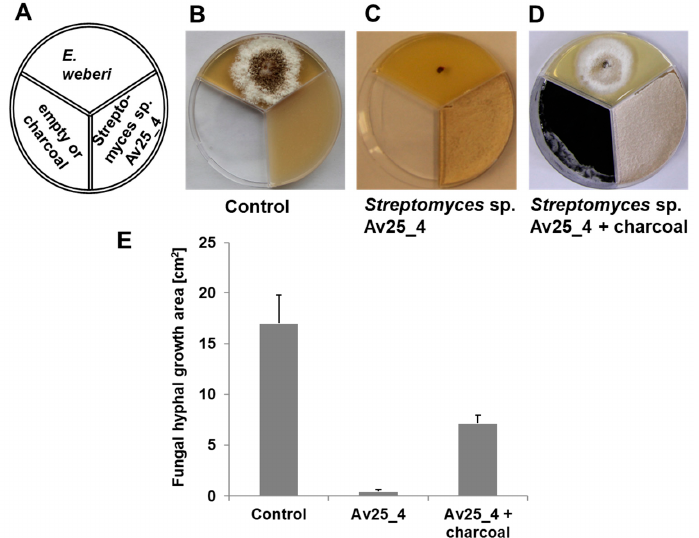
Figure 2. Antifungal activity of volatiles produced by Streptomyces sp. Av25_4 against E. weberi with and without activated charcoal in the third compartment. ( A ) Scheme of the experimental setup. ( B ) E. weberi grown for 4d in the first compartment. ( C ) E. weberi grown for 4d in first compartment and Streptomyces sp. Av25_4 grown for 7d in the second compartment. ( D ) E. weberi grown for 4 d in the first compartment, Streptomyces sp. Av25_4 grown for 7d in the second compartment and 2g acti- vated charcoal in the third compartment. ( E ) Quantification of the E. weberi growth area analyzed by image J.